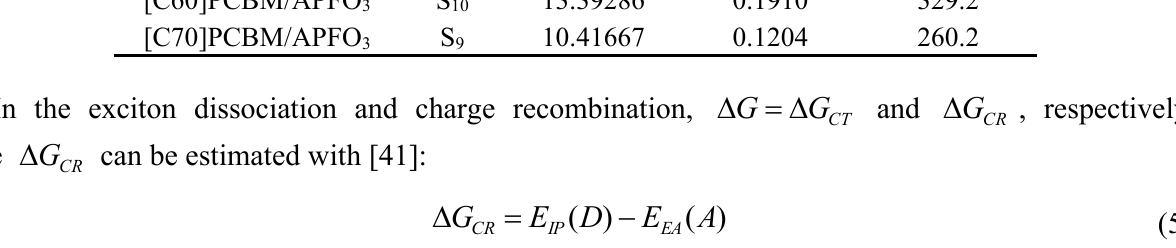
Table 3. Calculated dipole moment of state-to-state and coupling strength. Complex